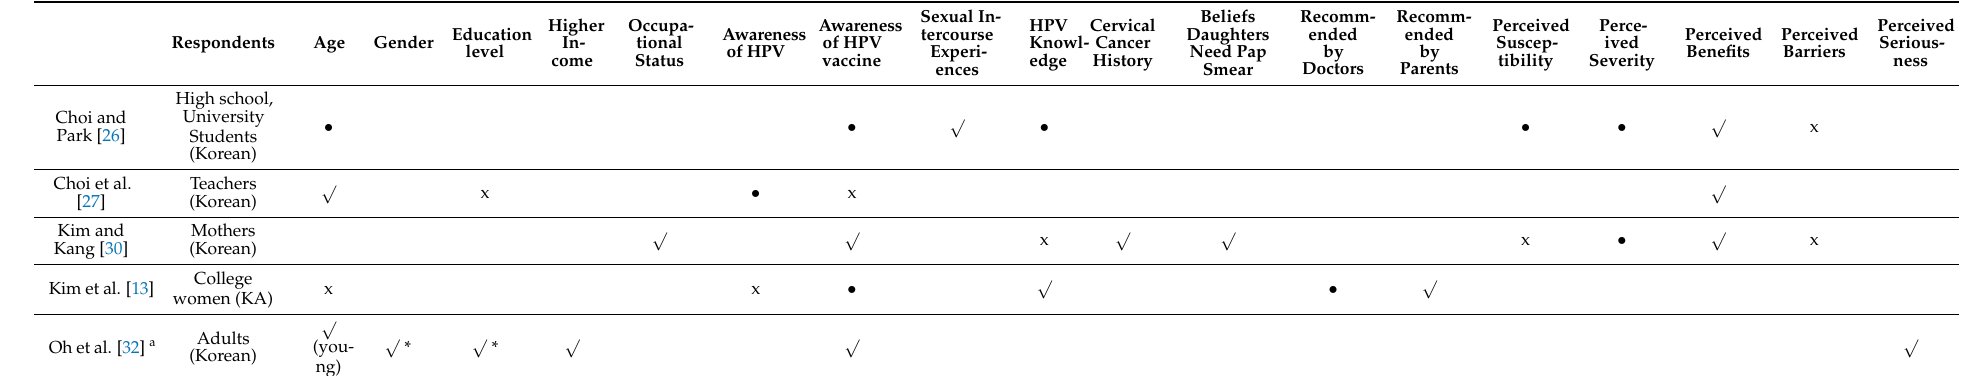
Table 3. The factors associated with HPV vaccination